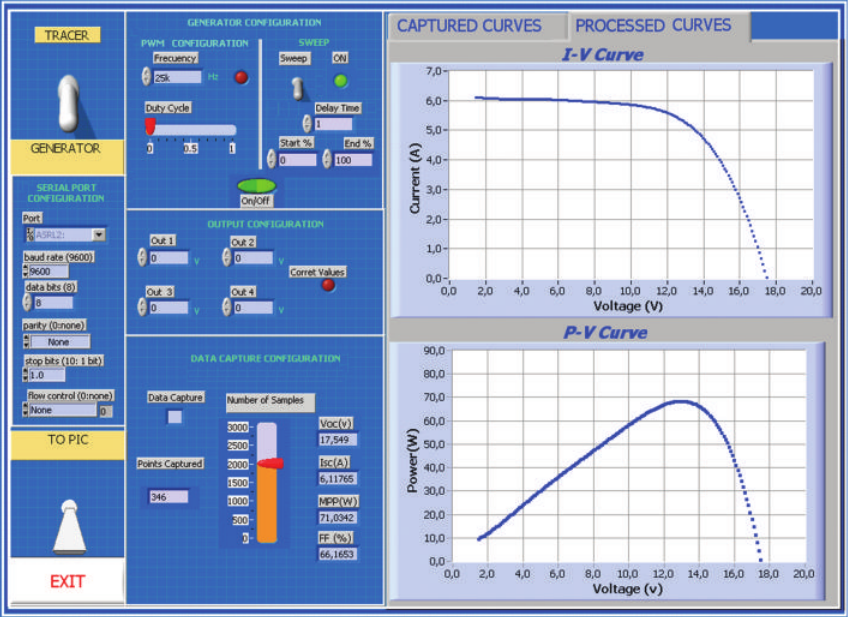
Figure 4: Virtual instrument based on LabVIEW interface.